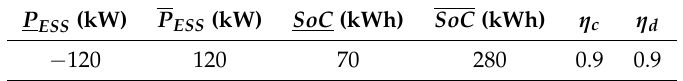
Table 2. Characteristic parameters of each of the generators considered in the